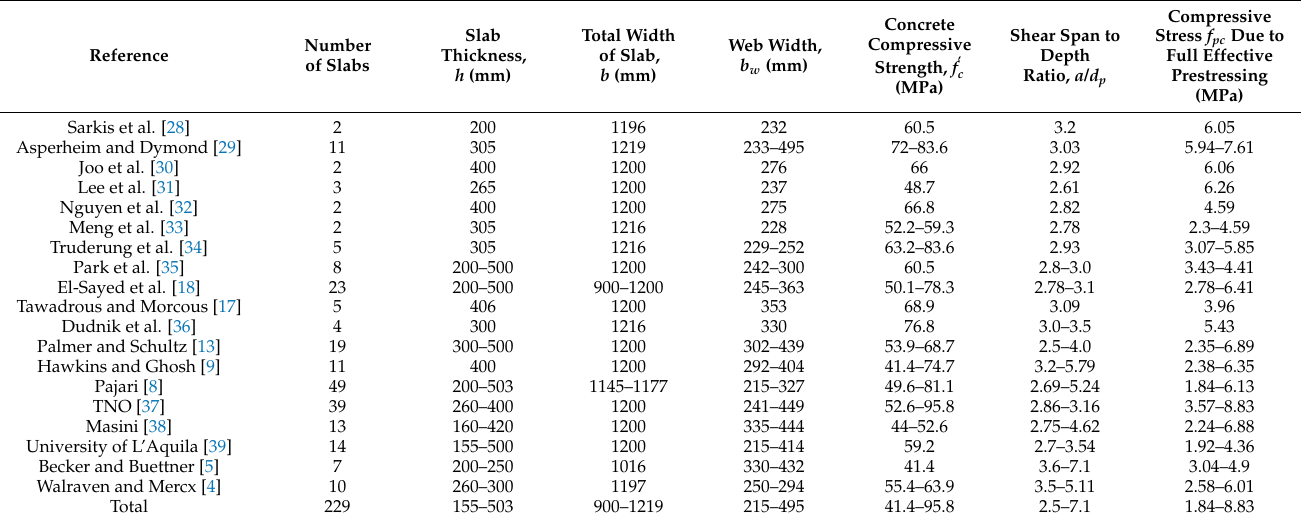
Table 1. Experimental database of prestressed HCS.